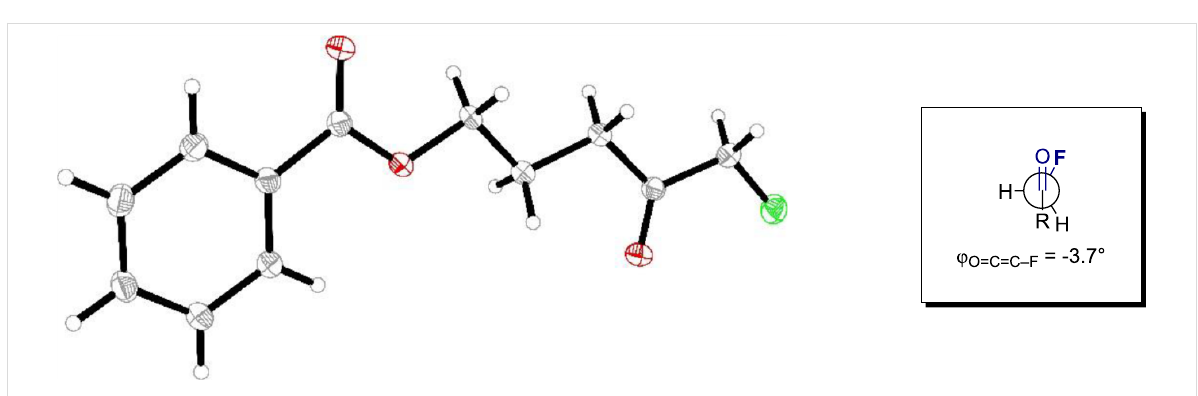
Figure 2: X-ray molecular structure of compound 2 . Conformation of the carbonyl group and the fluoride with a torsion angle of φ O=C-C-F = − 3.7°. CCDC number 2000136.